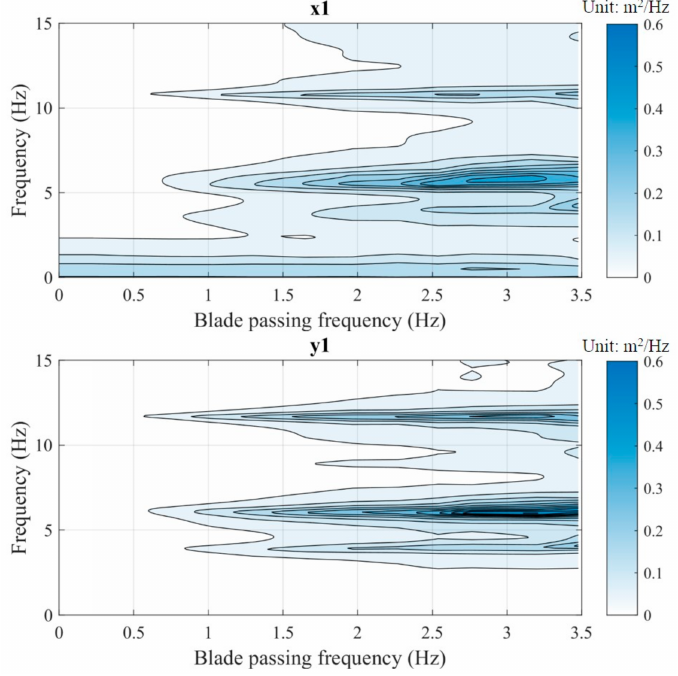
Figure 13. Vibration amplitude versus turbine blade passing